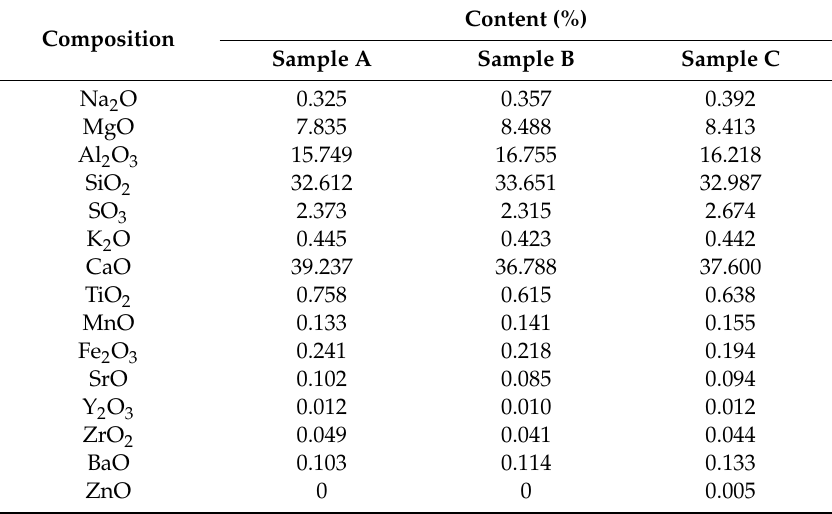
Figure 2. XRD spectra for three investigated samples. Table 3. Composition and content for the three investigated samples.